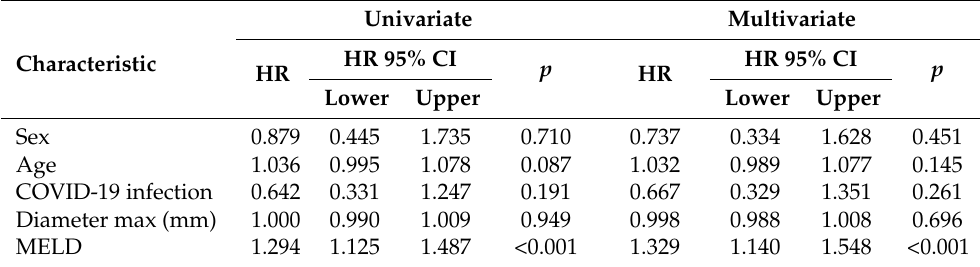
Table 2. Association of outcome and demographic and clinical characteristics. (univariate and multivariate Cox regression